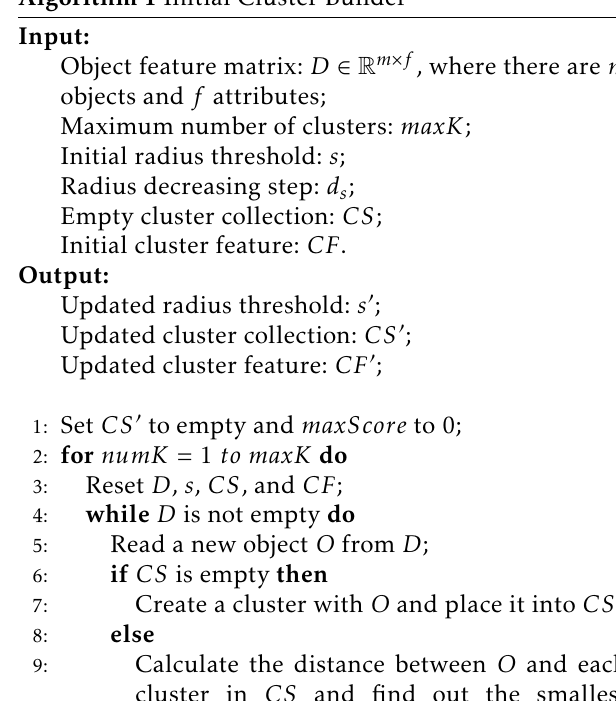
Algorithm 1 Initial Cluster